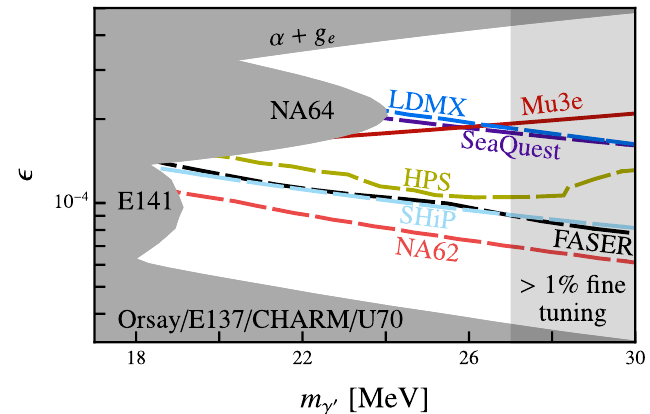
Figure 2 . Existing and projected constraints on dark photon parameter space. Our MTH model is viable for all values of (cid:15) currently unconstrained in the mass range 18 MeV . m (cid:13) 0 . 27 MeV. The beam dump constraints are from the compilation [58], while the (cid:11) + g e constraint is from [59]. The lines are projected constraints from LDMX [60], Mu3e [61], SeaQuest [62], HPS [63], SHiP [64], FASER [65], and NA62 [66]. Dashed lines would rule out the space below the line and solid lines would constrain the space